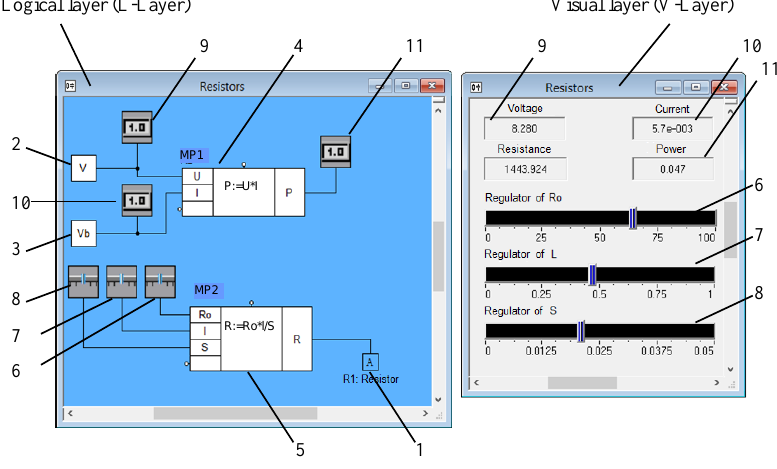
Fig. 5. Logical and visual layers of the Ohm's Law TIM in MARS SE Resistance variation will be achieved by changing the parameters of the resistor, and resistance value will be calculated automatically. Regulators 6, 7, 8 are used to set the specific resistance Ro, length L and cross-section area S. These regulators are set up in the logical level and automatically displayed in the visual layer. Graphical